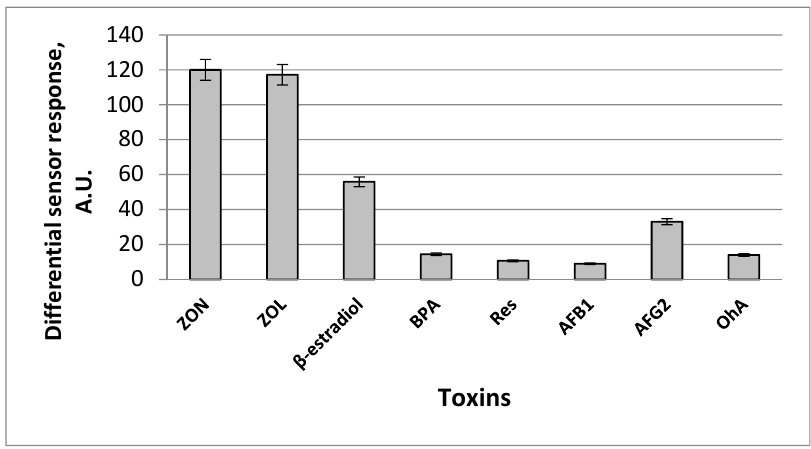
Figure 7. Cross-reactivity of differential sensor signals of zearalenone-selective fluorescent sensor after addition 1 µg mL − 1 of zearalenone (ZON) and its potential interferents and close structural analogues: α -zearalenol (ZOL), 17- β -estradiol, bisphenol A (BPA), resorcinol (Res), aflatoxins B1 (AFB1), aflatoxin G2 (AFG2) and ochratoxin A (OhA) in the analysed sample (working solution: 20 mM Na-phosphate buffer, pH 6.0, containing 150 mM NaCl, and 10% acetonitrile). Differential sensor response is a residual between sensor signals obtained by fluorescent sensors based on MIP and corresponding reference polymeric membranes.